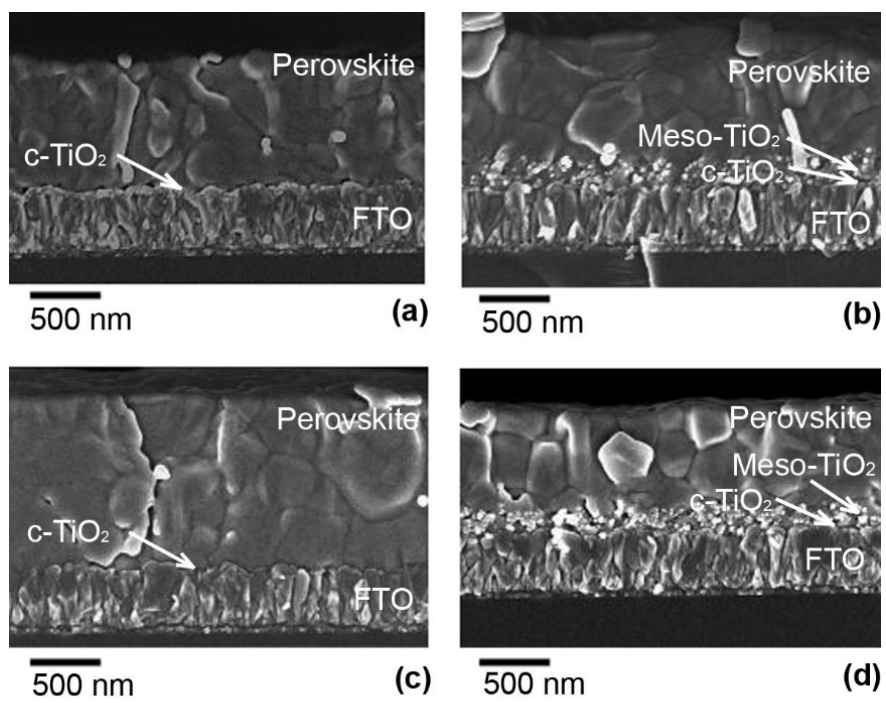
Figure 5. Cross-sectional SEM images of perovskite films on different TiO 2 layers: ( a ) Film A on the compact TiO 2 layer, ( b ) Film B on the mp-TiO 2 layer/c-TiO 2 , ( c ), Film C on the compact ALD-TiO 2 layer, and ( d ) Film D on the mp-TiO 2 layer/ALD-TiO 2 .